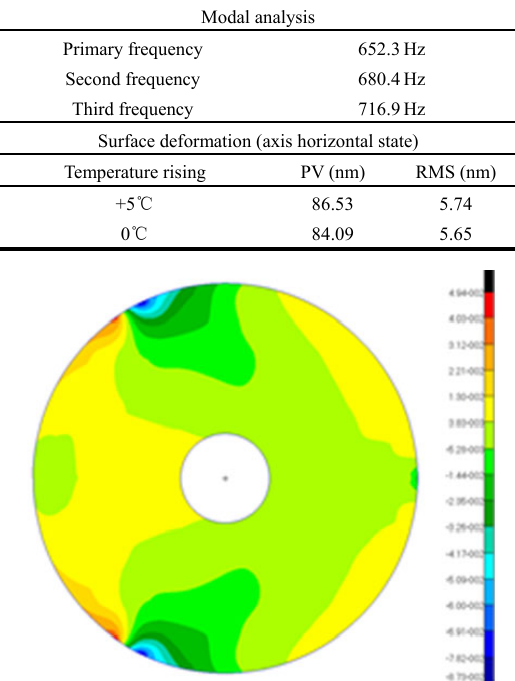
Fig. 13 Mirror surface deformation nephogram under gravity affection coupling with +5 ℃ temperature rise at optical axis horizontal